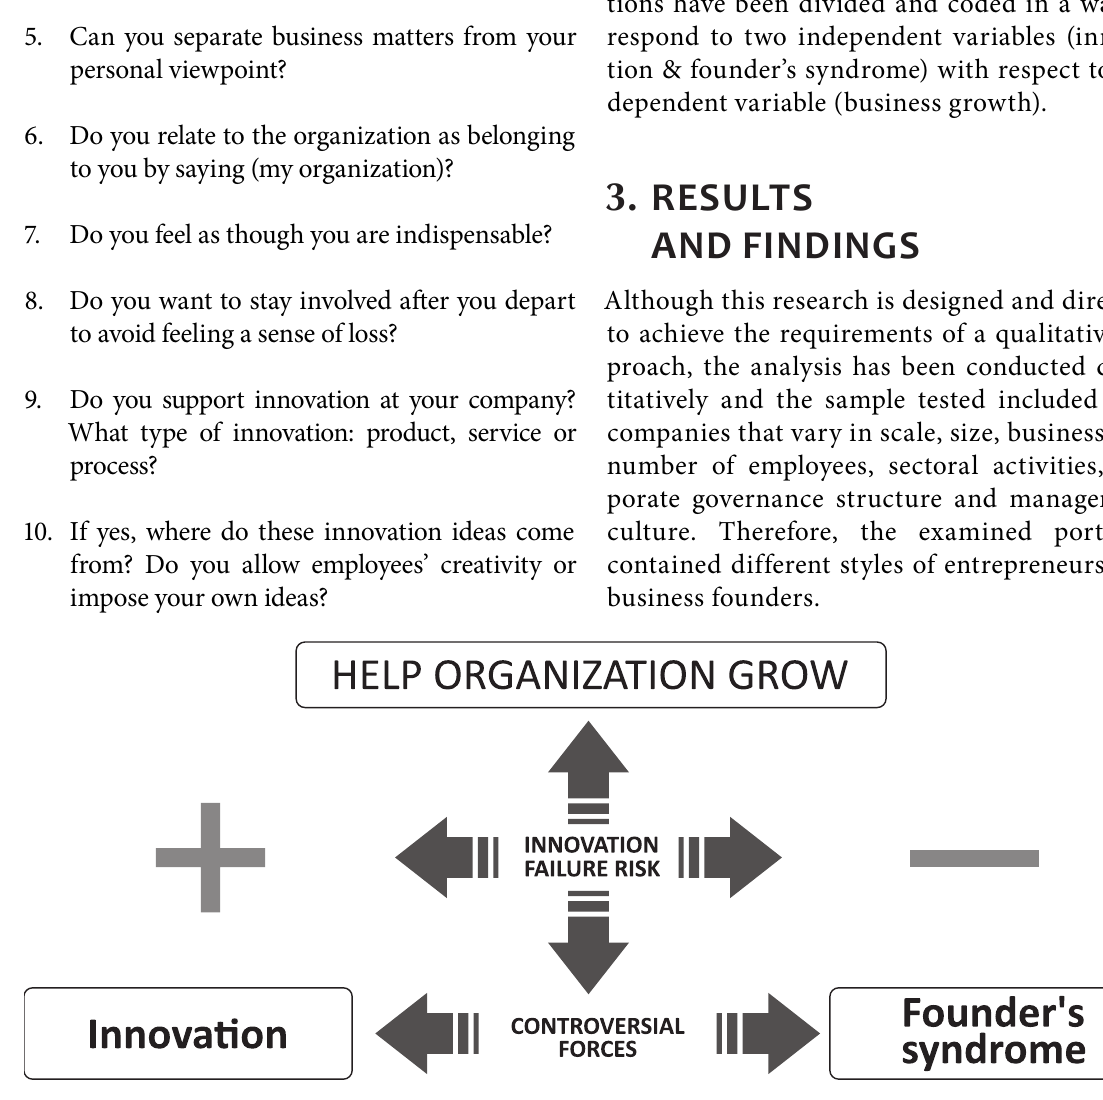
Figure 1. The model for